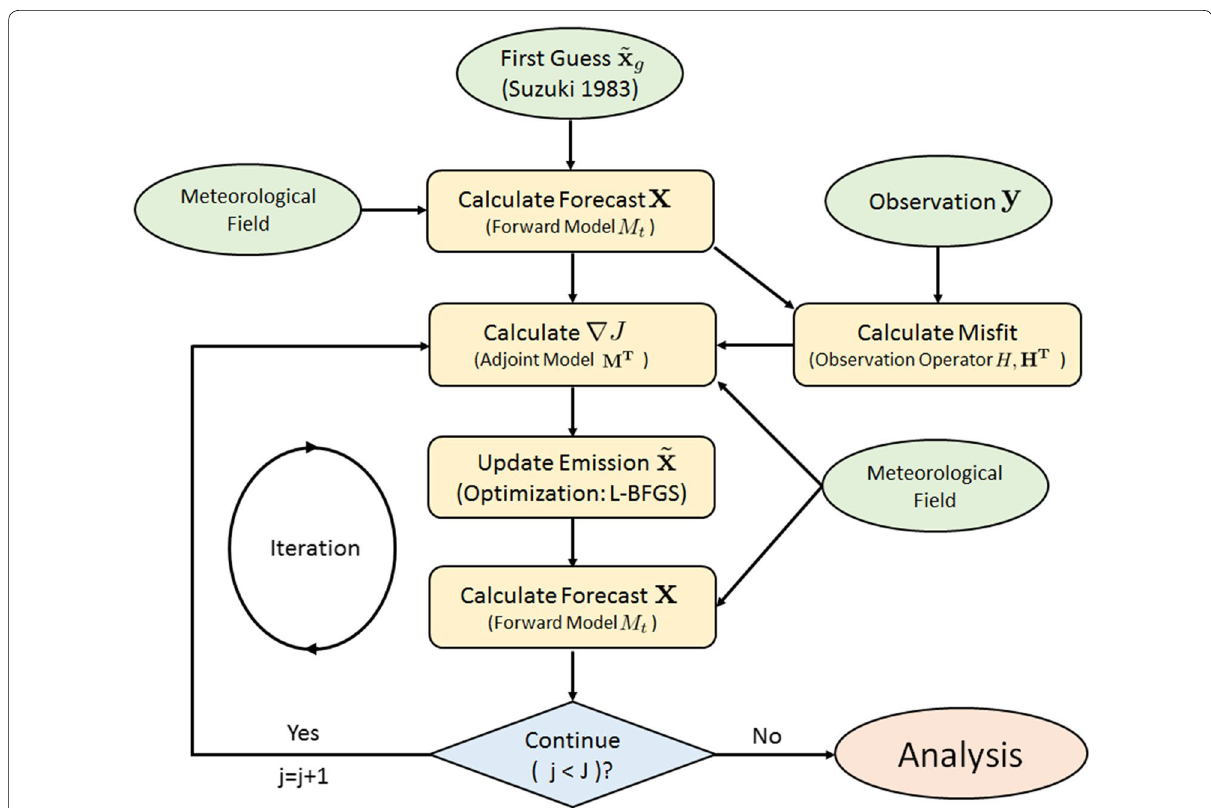
Fig. 1 Schematic showing 4D-Var iterative procedure in this